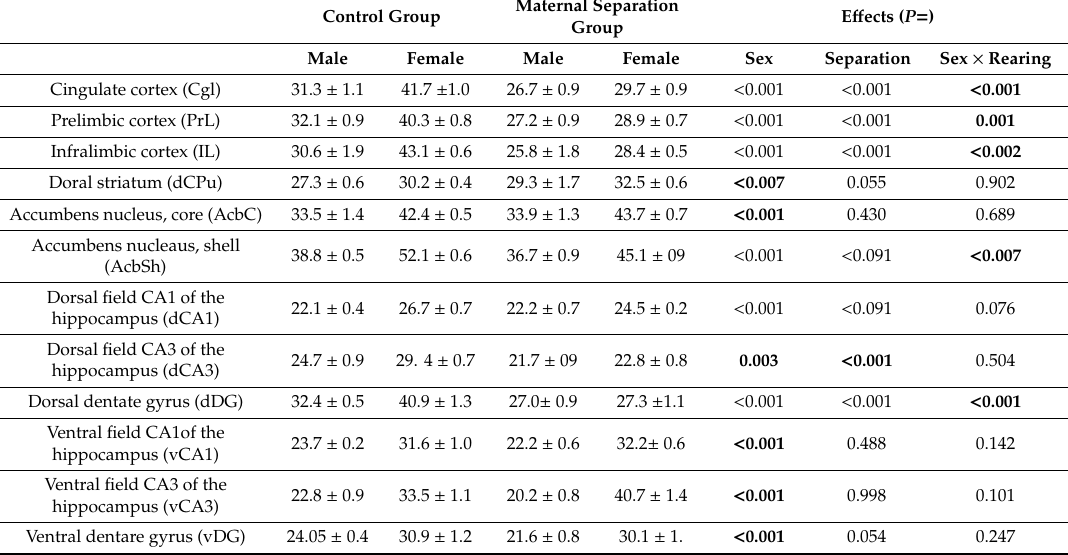
Table 1. Sex-specific e ff ects of early life stress in regional brain CCO activity of adult rats. Data are expressed as mean ± standard